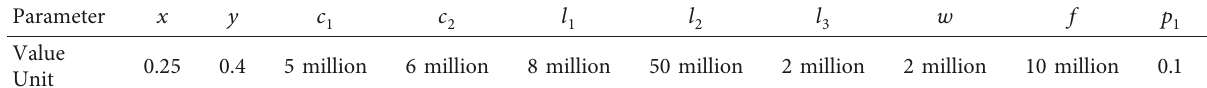
Table 4: Initial values of the simulation.